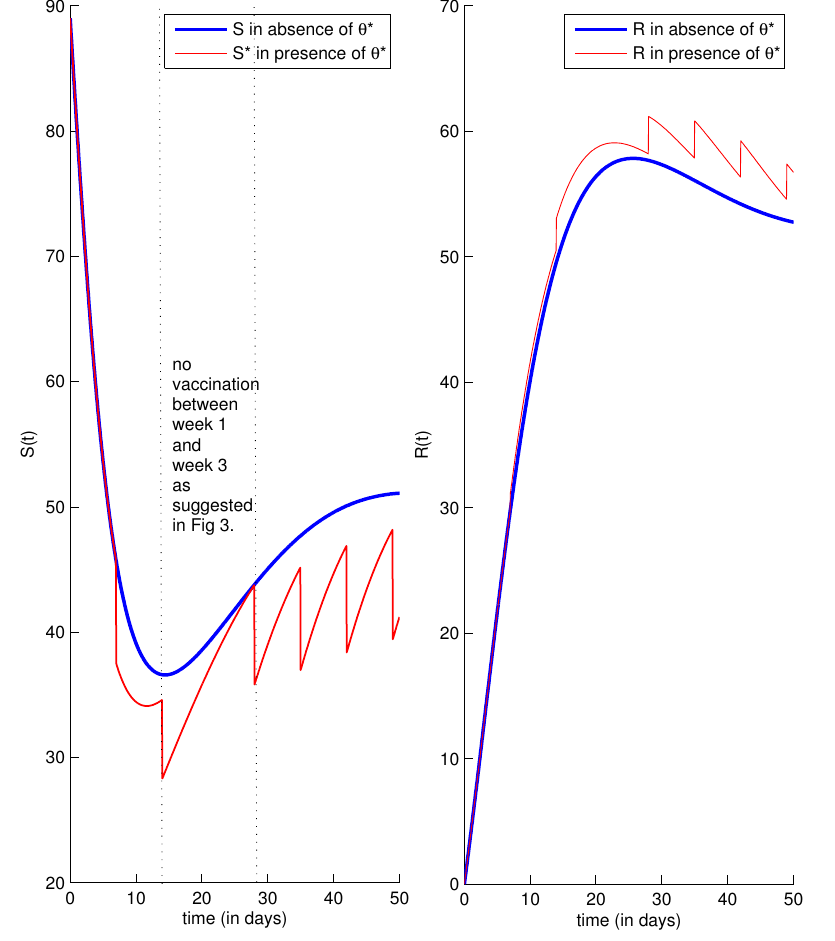
Figure 1. Case ( a ): Number of susceptible people in the absence and presence of control. Case ( b ): Number of removed people in the absence and presence of control. Parameters values: Π = µ N 0 , a = 1, b = 0.1, β = 0.003, µ = 0.05, γ = 0.1. Initial conditions: S ( 0 ) = 89, V ( 0 ) = 0, I ( 0 ) = 40, R ( 0 ) = 0. Severity weights constants: A = 0.1 and B =